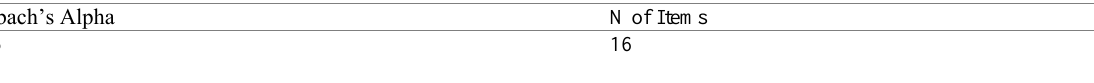
Table 6: Reliability Analysis and Cronbach’s